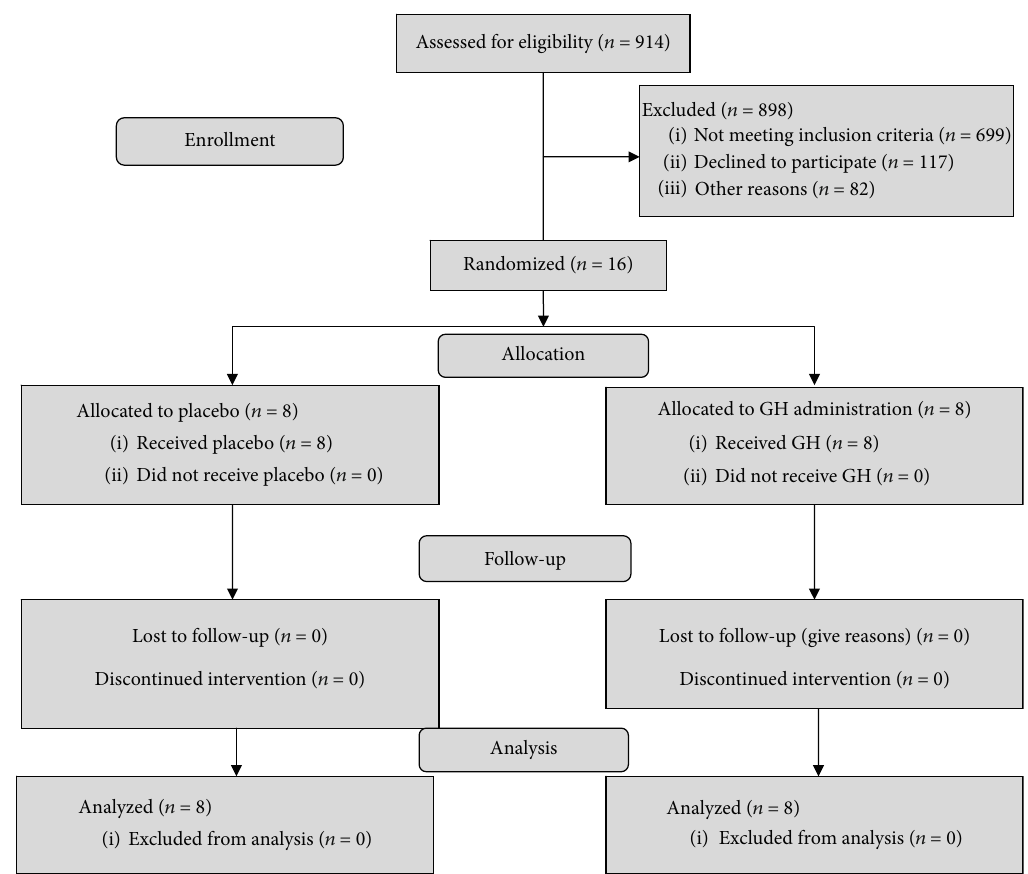
Figure 1: Flow diagram of trial pro fi